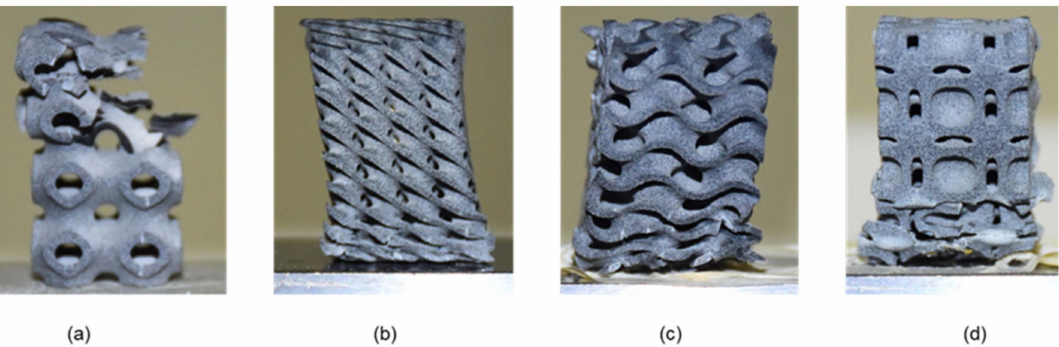
Figure 6. Samples with deformation in the 2 × 2 × 4 arrangement. Design failures occur in the following ways: ( a ) Schwarz-P design fails due to the propagation of crack from stress concentration points; ( b ) Diamond design fails in the same share plane where uniform deformation occurred. ( c ) Gyroid design fails at the bottom end where the load is transferred and ( d ) Neovius design fails due to the propagation of crack from stress concentration points.